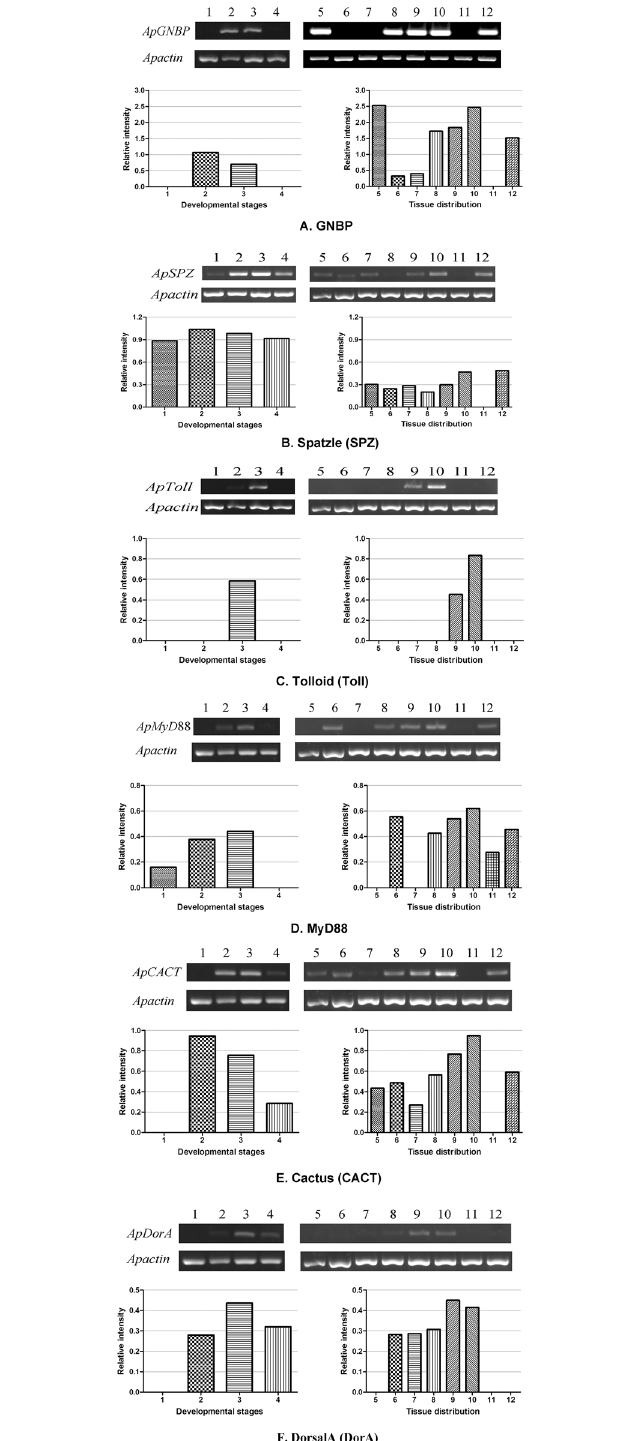
Fig 4. Expression and relative intensity of genes in the Toll pathway during different developmental stages and in different tissues of 5 th instar larvae in A . pernyi . Lane 1, eggs on the 5th day; lane 2, 5th instar larvae; lane 3, pupae; lane 4, moths; lane 5, epidermis; lane 6, silk gland; lane 7, blood; lane 8, gonads; lane 9, Malpighian tubules; lane 10, fat body; lane 11, midgut; lane 12, muscle.